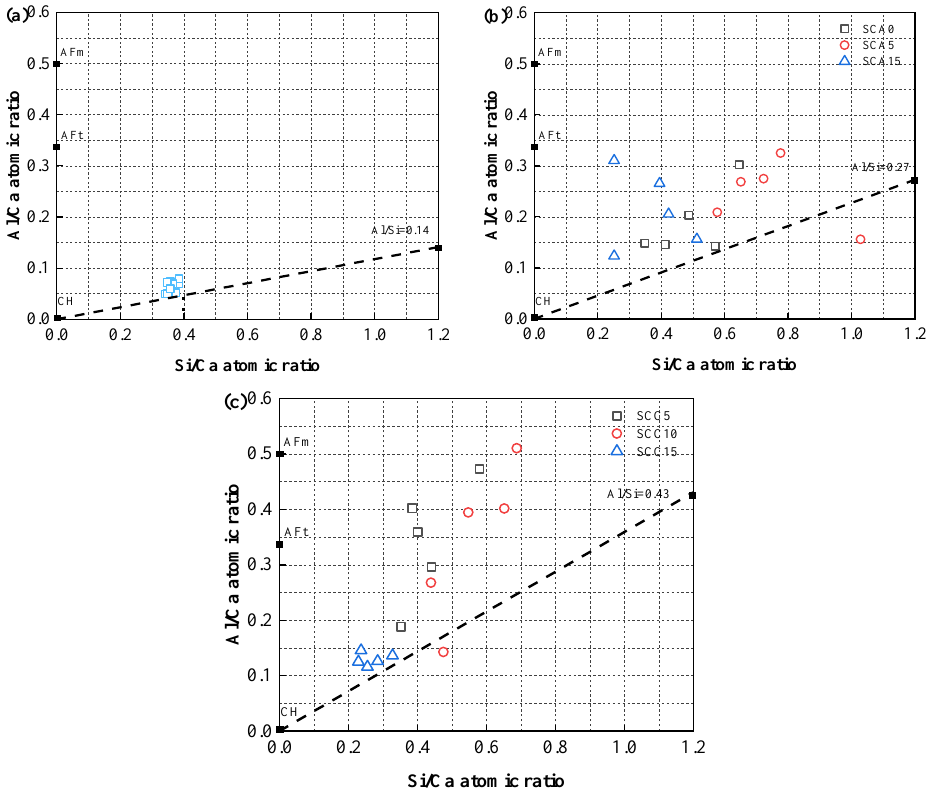
Figure 13. SEM observation of binder pastes after 28 days of hydration (Mag = 5000×).